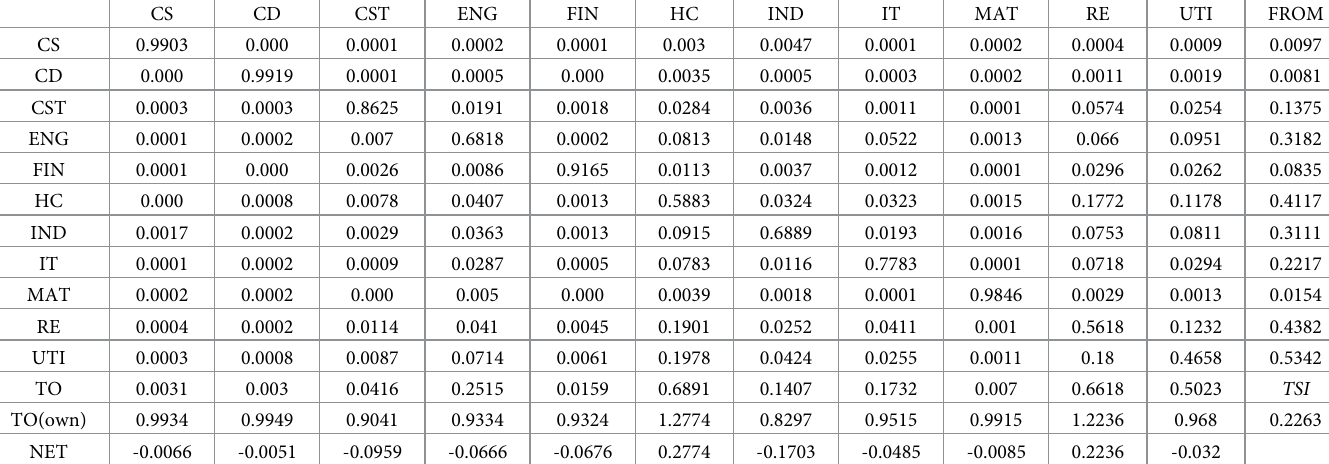
Table 2. Summary of liquidity spillovers in all the sectors for the entire period. The forecast horizon is H = 30. The optimal lag order is determined by the AIC. Notes: TSI = total spillover index in (6); FROM = DS i � ( H ) in (7), total liquidity spillovers received by the i -th sector from all other sectors; TO = DS � i ( H ) in (8), total liquidity spill- overs transmitted by the i -th sector to all other sectors; TO (own) = total liquidity spillovers generated by the i -th sector, including the contribution of its own; NET = NS i ( H ) in (9), net spillovers (the difference between transmitted liquidity shocks and received liquidity shocks).